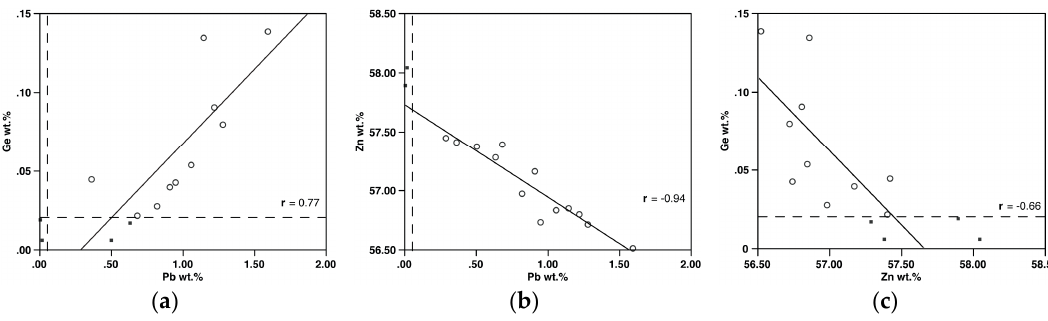
Figure 6. ( a ): Ge wt % vs. Pb wt %; ( b ) Zn wt % vs. Pb wt %; and ( c ) Ge vs. Zn wt % for the zoned willemite shown in Figure 4. Closed symbols plotting below the dashed line, which indicates detection limit, were not used in plotting regression line nor in calculating r value.